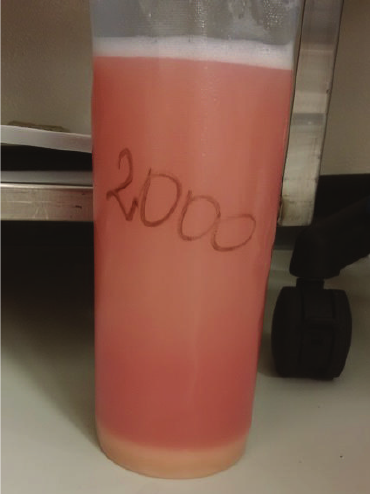
Figure 3: Photograph of the BAL fluid, demonstrating an opaque, milky appearance.